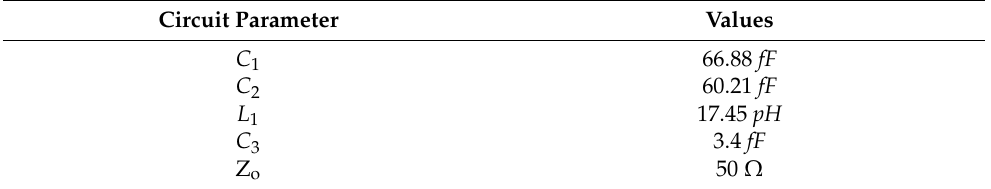
Table 3. RLC parameters of the